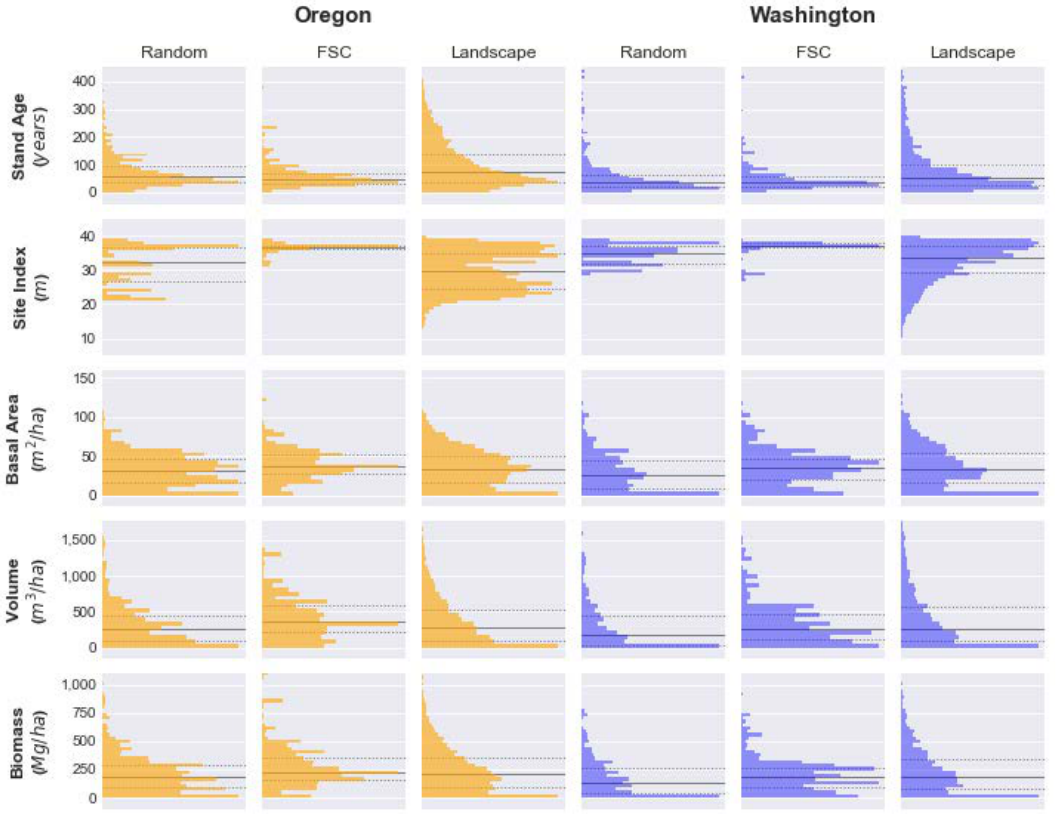
Figure 3. Correspondence between selected parcels and the surrounding landscape. The “surrounding landscape” refers to the extent of the US Environmental Protection Agency Level 3 Ecoregions in western Oregon and Washington which include the sampled parcels. Only areas with forest landcover according to the Gradient Nearest Neighbor Plot Database for 2014 [35] are included in the calculation of these distributions, which are visualized with a histogram based on counts of 30 × 30-m pixels within each area of interest. Horizontal lines in each graph showing the 25th and 75th percentiles (dotted lines) and median (solid line). Site Index refers to the height of dominant Douglas-fir trees at age 50, with values derived from Latta et al. [36].